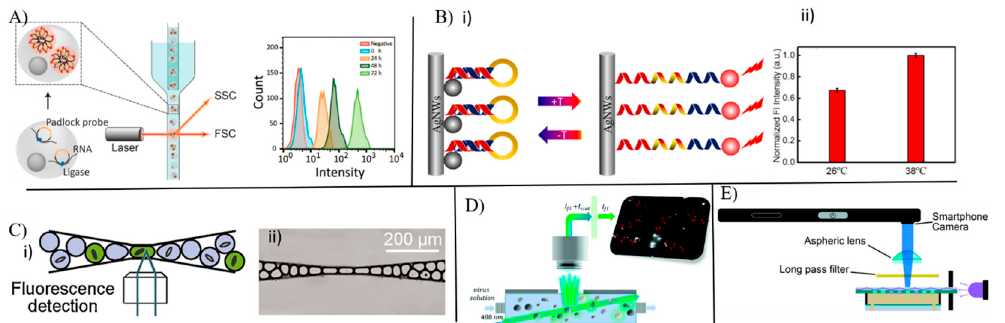
Figure 7 . Fluorometry–based sensing Schematic representation of ( A ) monitoring of single cell gene expression levels using padlock probes which are designed specifically to detect target nucleic acids, which is then ligated by ligase enzyme, amplified through rolling circle amplification, and analyzed through flow cytometry. FSC: forward scatter, SSC: side scatter (reproduced with permission from [121]). ( B ) Single cell DNA thermometer functioned through conformational changes (i) and varia- tions in fluorescence intensity (FI) (ii) at two temperatures (reproduced with permission from [103]). ( C ) (i) Microfluidic in-droplet analysis of antibiotic resistance detection using fluorescence sensing and (ii) microscopic image of the sensor chip (reproduced with permission from [124]). ( D ) Single cell counting and size determination using fluorescent aptamers attachment to targets (reproduced with permission from [104]). ( E ) Smartphone interfaced fluorescent imaging platform for digital counting of virus (reproduced with permission from [105]). Nowadays, miniaturized optofluidic platforms have also been developed which pro- vide on-chip sample preparation, manipulation, and quantification of cells [125]. For in- stance, Lyu et al. were able to demonstrate automated phenotypic microscopic quantifi- cation of antibiotic resistance at the single cell level through the droplet encapsulation of cells (Figure 7C(i,ii)). The droplets act as test chambers for reactions that involve the cells, antibiotics, and a cell viability fluorescence marker [124]. Developments towards digital detection platforms facilitating the detection of single viruses are gaining impetus for early diagnosis and biological security [126]. For example, single viruses were captured using specific fluorescent-tagged aptamers for detection, counting, and sizing by nano- particle tracking analysis (Figure 7D) [104]. However, for translation to PoC devices with many such systems, further efforts are needed along the lines of interfacing. In this direc- tion, Minagawa et al. produced a digital detection method for influenza virus counting using a fluorometric method, interfaced with a smartphone camera-based image readout (Figure 7E) [105]. 3.3. Single Circulating Tumor Cell Detection CTCs are considered a significant biomarker of cancer diagnosis and prognosis, though the challenges emerge typically in their detection. A milliliter of blood contains millions of white blood cells, billions of red blood cells, and only a few CTCs. Microfluidic enrichment strategies have been proposed harnessing the physical and biological proper- ties of the CTCs, as discussed in the sample preparation section of this review. Presently, CellSearch, an FDA-certified system, is considered the gold standard for capturing and quantifying CTCs from approximately 7.5 mL of blood sample [127]. Nevertheless, this technology is only limited to CTCs expressing epithelial cell adhesion molecules. Alterna- tive methods for detection and enumeration of CTCs are currently being explored. SERS nanoprobe was prepared to utilize tetrahedron DNA assembly to electrostatically interact with positively charged AuNPs to obtain a tetrahedron AuNP assembly (Figure 8A(i)) [128]. The nanoprobe utilized EpCAM aptamers which bind specifically to the surface an- tigens of CTCs. The nanoprobe-enabled SERS spectral analysis (Figure 8A(ii)) could detect 3–500 CTCs/mL under optimal conditions.